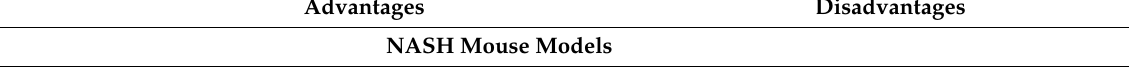
Table 1. Cont . Advantages Disadvantages NASH Mouse Models Genetic